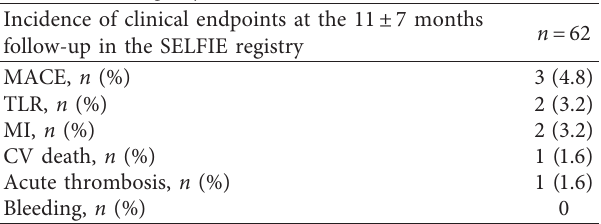
Table 3: Incidence of clinical endpoints at 11 ± 7 months follow-up in the SELFIE registry.